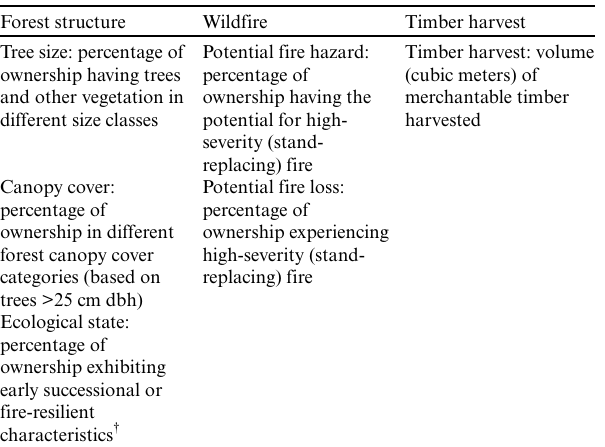
Table 2. Metrics used to evaluate relative differences in forest resilience to stand-replacing wildfire Forest structure